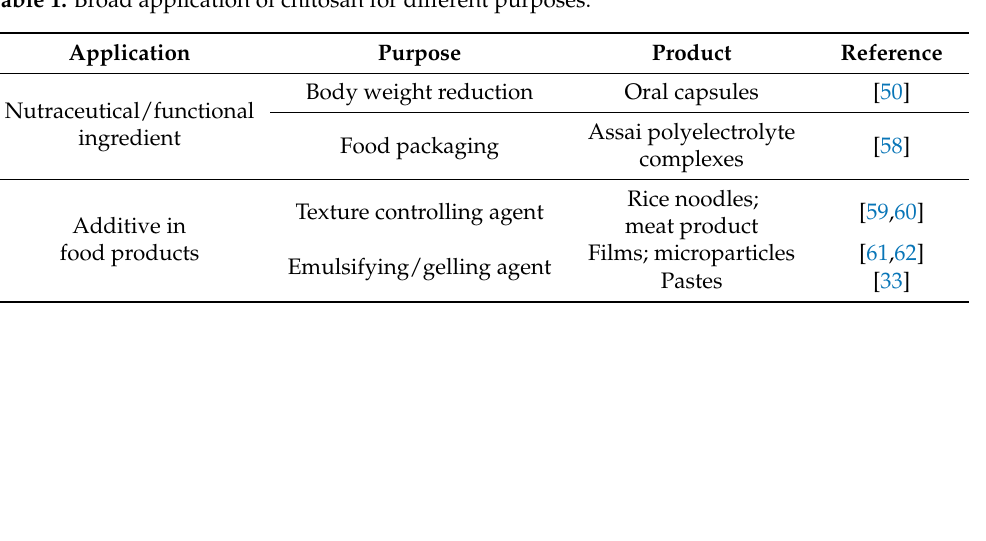
Table 1. Broad application of chitosan for different